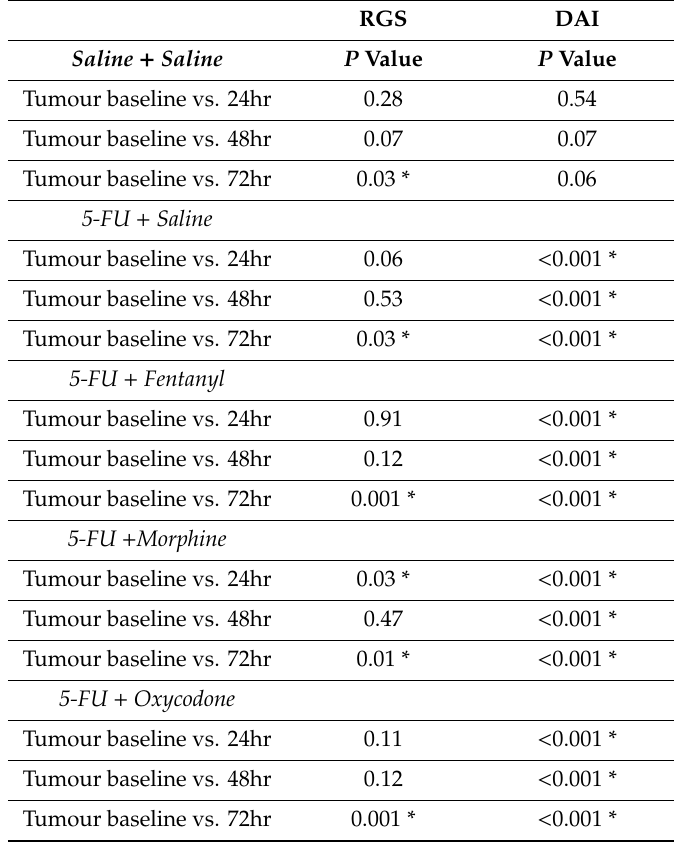
Table 2. Statistical comparison within group across time for RGS and